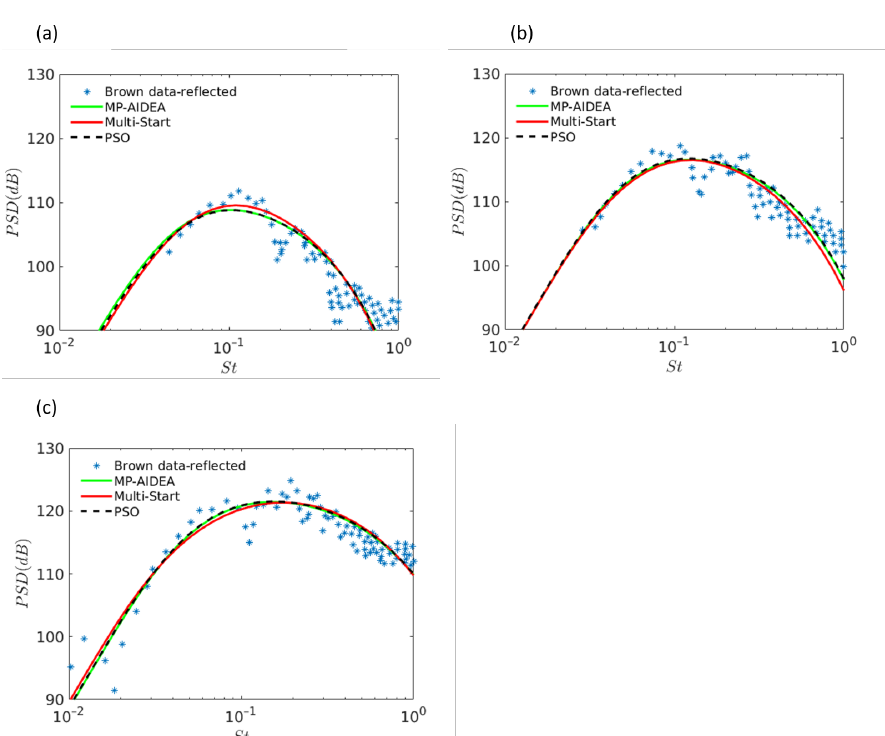
Figure 11. Comparison of acoustic predictions using different optimization routines for method 3